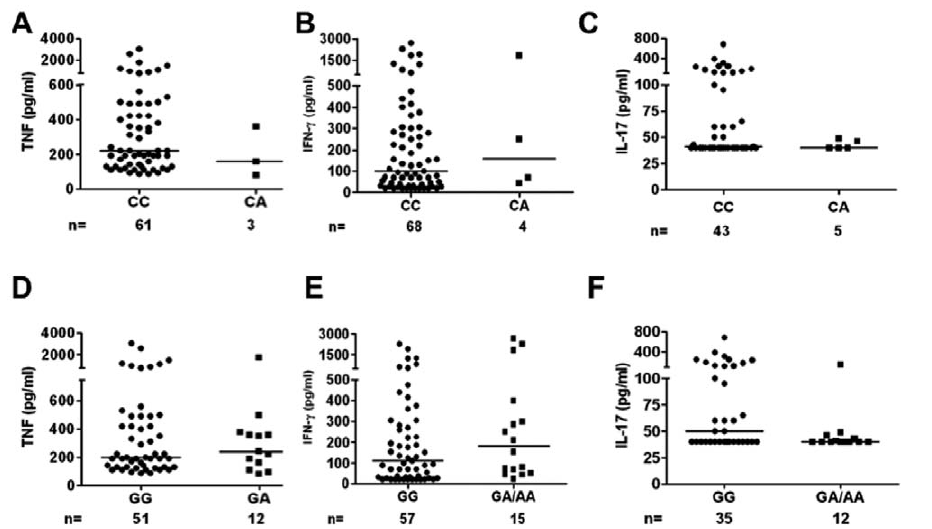
Figure 2. Scatter plots of TNF, IFN- c , and IL-17 produced after stimulation of PBMC with M.tuberculosis stratified for genotypes of both investigated polymorphisms in IRGM . doi:10.1371/journal.pone.0041618.g002 treatment. The distribution of the alleles for all polymorphisms among patients infected with M. tuberculosis Beijing and non- Beijing strains is shown in Table 4. The polymorphism in LAMP1 (rs9577229) showed an association with TB caused by M. tuberculosis Beijing strains, when the TC was combined with the low prevalent TT genotype (p =0.02). The same was true for the